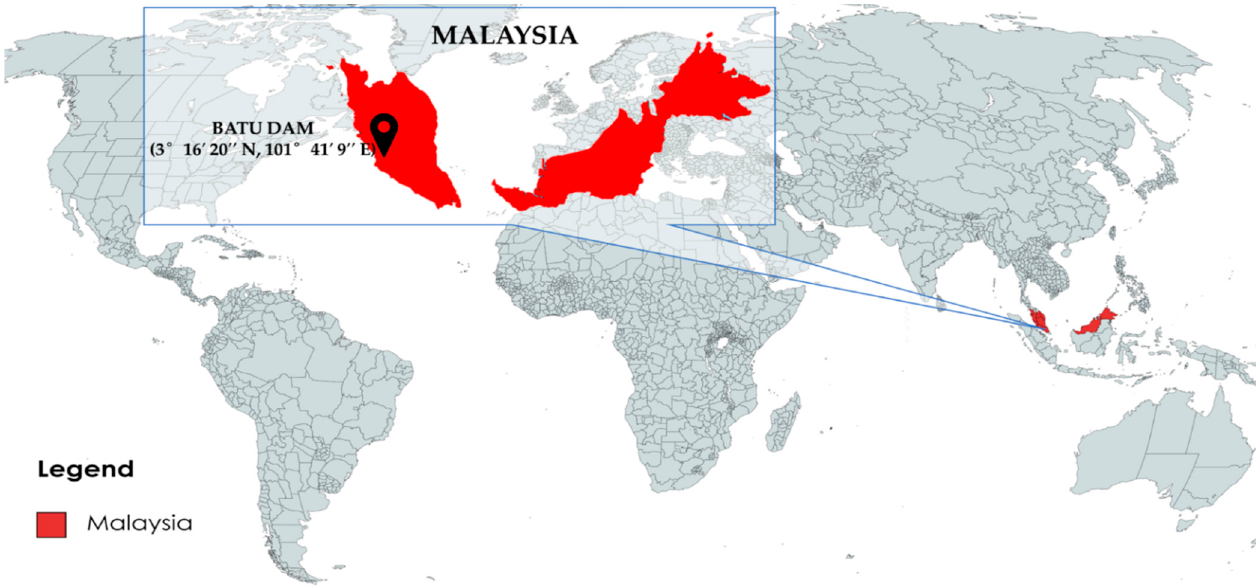
Figure 1. Location of Batu Dam, Malaysia in World Map.